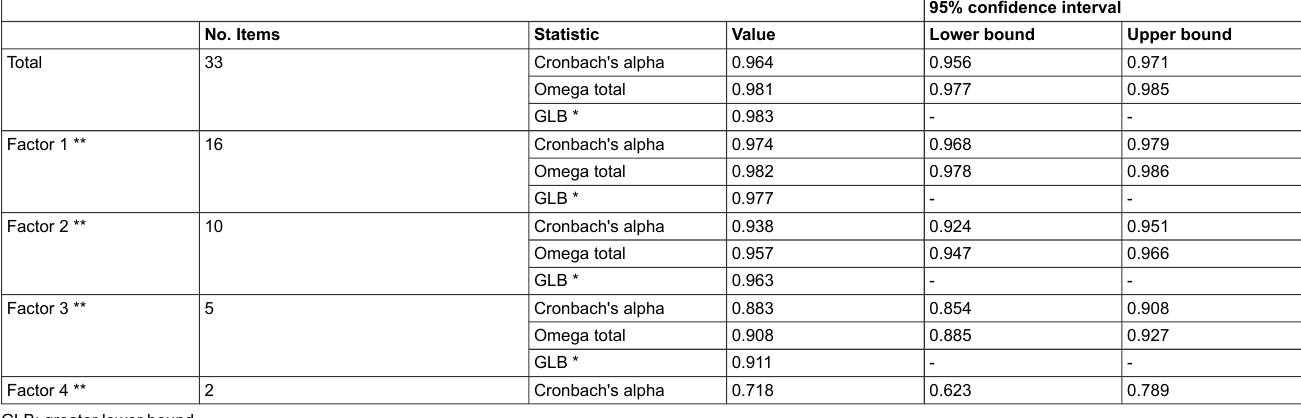
Table 3: Measurements of internal consistency for total and factor scores.